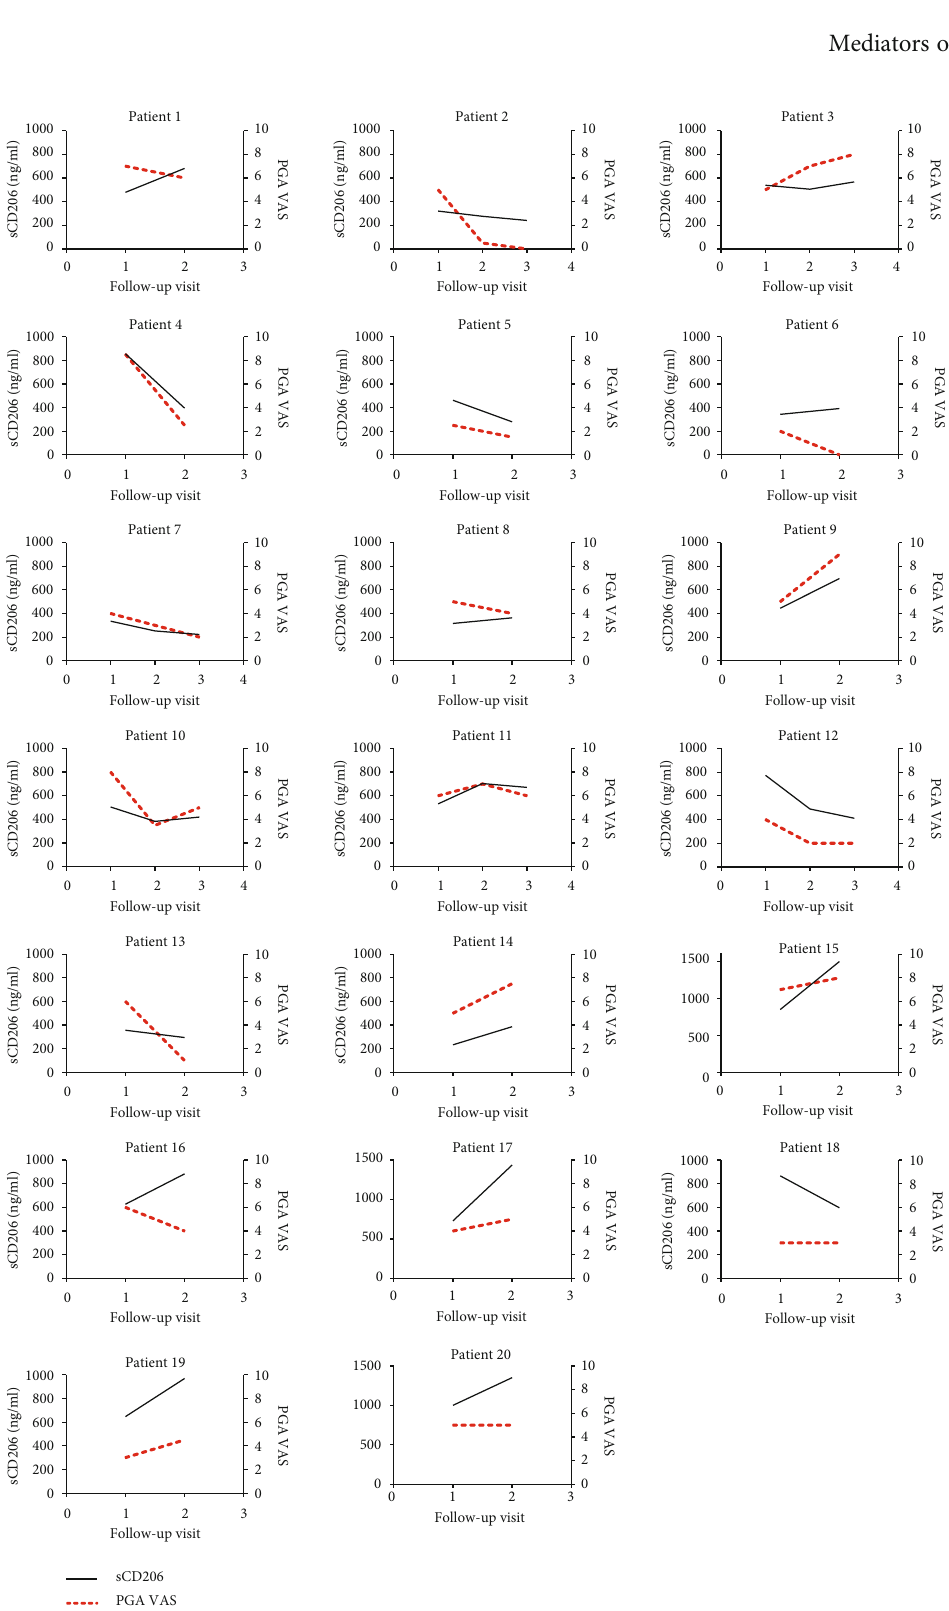
Figure 6: The longitudinal analysis of sCD206 levels and PGA VAS in 20 patients with DM, respectively. sCD20: soluble CD206; DM: dermatomyositis; VAS: visual analog scale; PGA: physician global